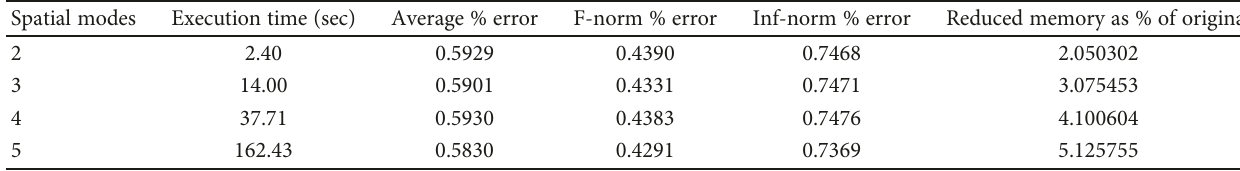
Table 8: Density in an y × z plane with i = 2 .